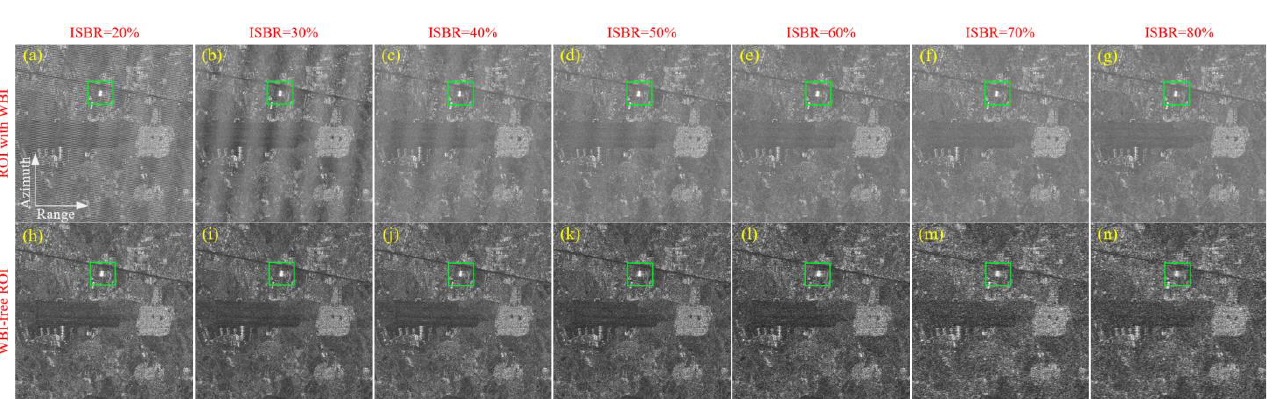
Figure 8. ROIs in Figure 7a – n with green boxes. ( a – n ) Strong point targets with green boxes.